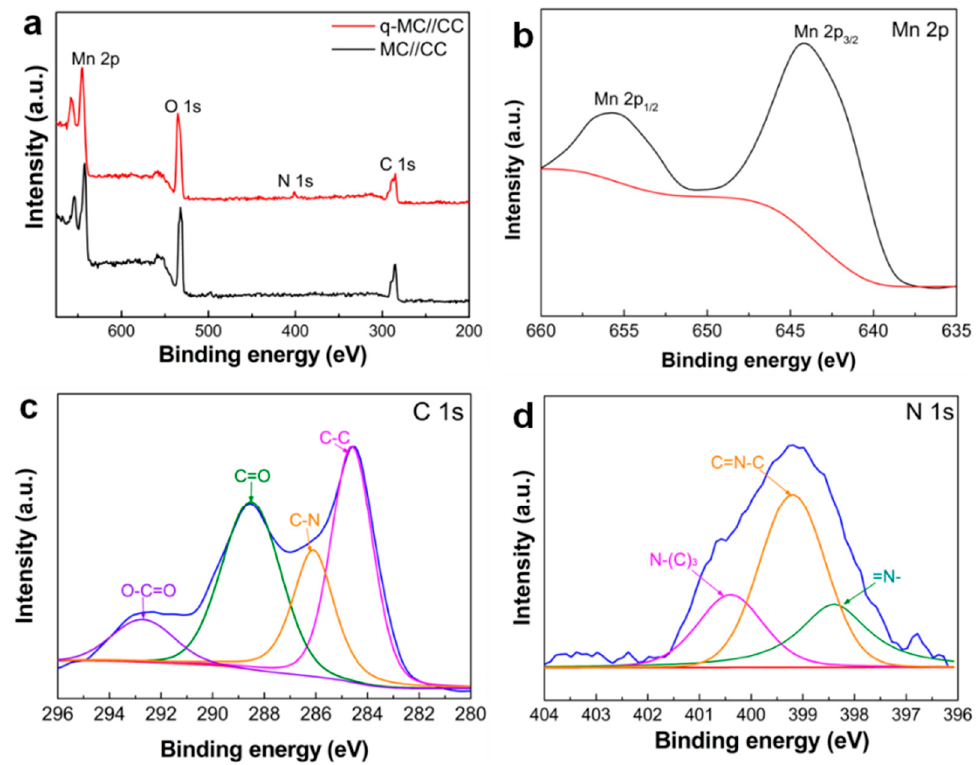
Figure 3. ( a ) XPS full survey scan of q-MC//CC and MC//CC. ( b – d ) High-resolution XPS of Mn 2p, C 1s, and N 1s of q-MC//CC, respectively. and N 1s of q-MC // CC,